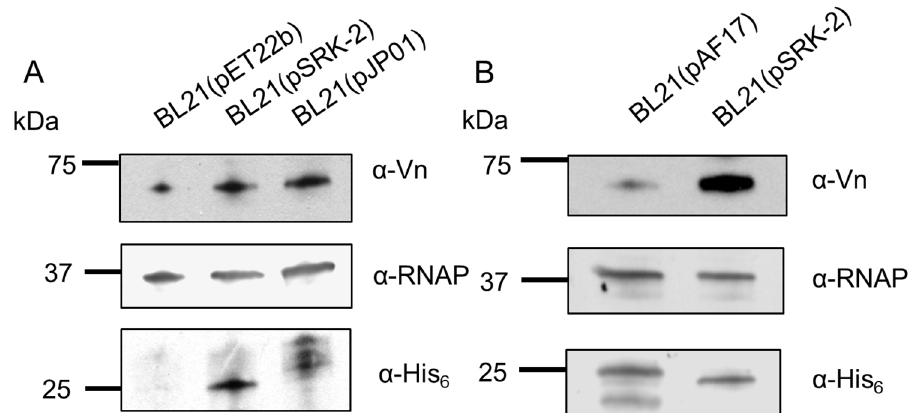
Fig 4. R . conorii Adr2 binds complement regulatory protein vitronectin. (A) E . coli BL21 harboringthe empty vector pET22b, the plasmidencoding R . conorii His 6 -tagged Adr2 (pSRK-2) or R . conorii His-tagged Adr1 (pJPO1) were incubatedwith normal humanserum. Western immunoblot analysisrevealed a reactive band at approximately 75 kDa in all lanes except for the empty vector when probedwith antibody raised againstvitronectin. Expression of both Adr2 and Adr1 was confirmedby anti-His 6 , and equalloadingwas demonstrated with anti- E . coli RNA Polymerase alpha (RNAP). (B) Western immunoblot analysisof multimeric vitronectinbindingto E . coli expressingAdr1 derivative mutant (pAF17) or R . conorii Adr2. Expression of both the Adr1 derivative and Adr2 was confirmedby anti-His 6 , and equal loadingwas verified using anti- E . coli RNA polymerase alpha